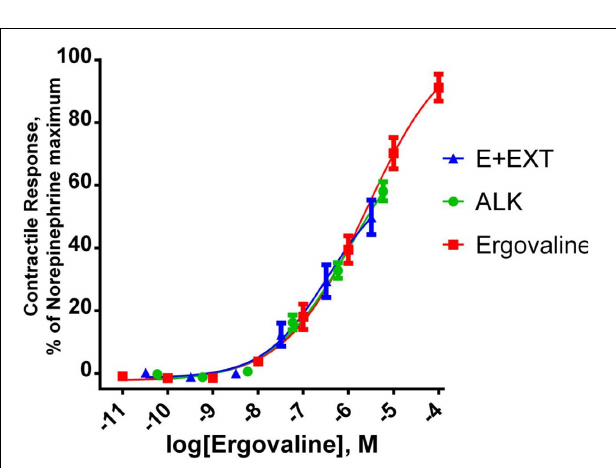
FIGURE 5 | Contractile response of bovine lateral saphenous vein. Response of bovine lateral saphenous vein to ergovaline, an endophyte-infected tall fescue seed extract (E + EXT) standardized to ergovaline concentration, and a mixture of ergot alkaloids (ALK) that reflects the alkaloid profile of E + EXT. Regression lines represent the fitting of data to a sigmoidal concentration response curve. The ALK treatment was prepared by dissolving ergovaline, ergotamine, α -ergocryptine, ergocristine D-lysergic acid hydrate, and ergonovine in 80% methanol. The alkaloid concentrations of this ALK treatment were based on alkaloids quantified in the E + EXT. E + EXT was prepared as described above for purification of the crude extract from the tub extractor. All treatment solutions were based on the ergovaline concentration. The other alkaloids in the E + EXT and the